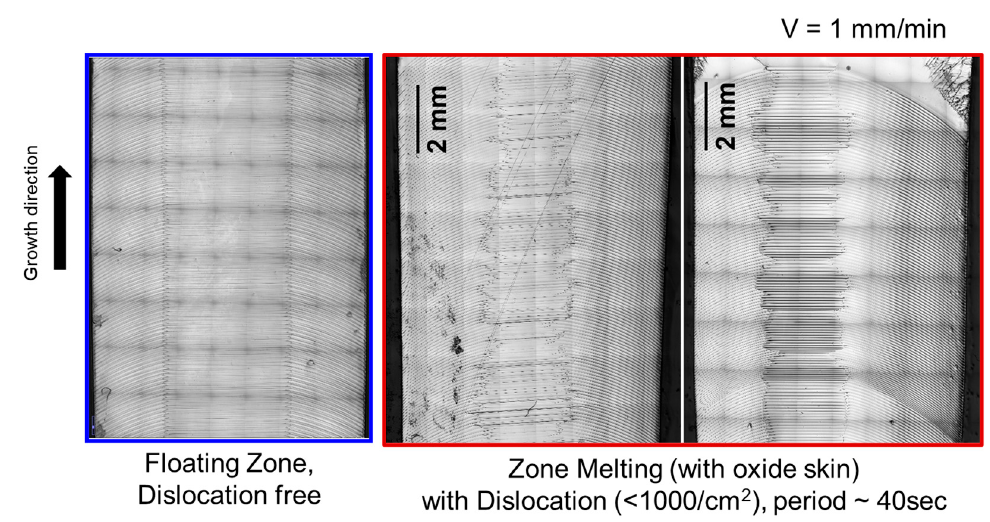
Figure 11. Microscope images of vertical cuts of three etched silicon samples to illustrate the evolution of the central facet in the <111>-oriented crystals. In all cases, the translation velocity was 1 mm/min. ( left ) Dislocation-free sample with a stable central facet diameter; ( middle ) dislocation-containing sample exhibiting fluctuations of the central facet diameter; ( right ) repetition of the experiment reproducing the results.